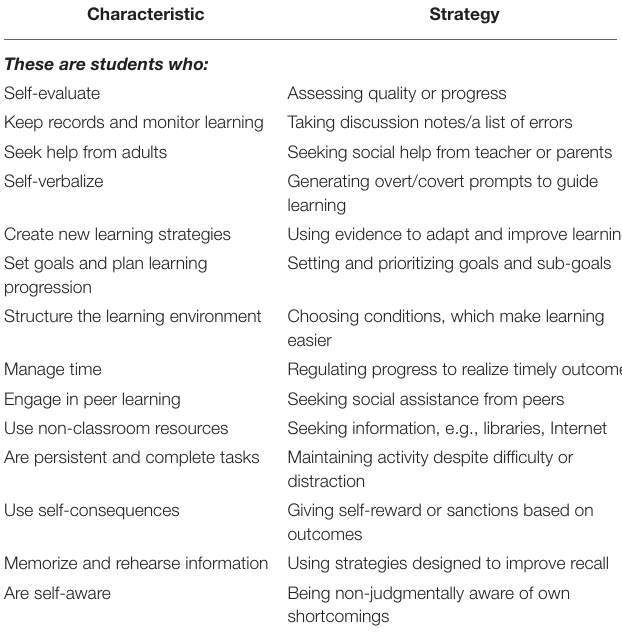
TABLE 1 | The characteristics of self-regulated learners and the meta-cognitive strategies they